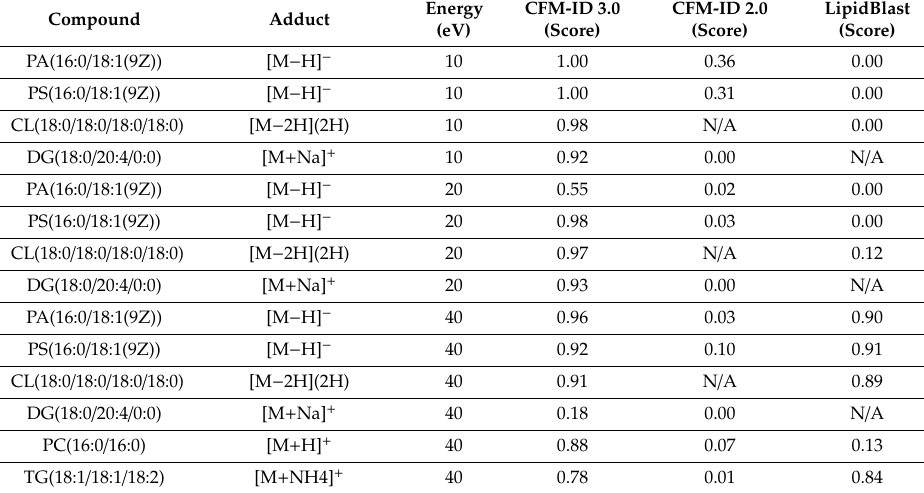
Table 3. Computed spectral similarity scores between experimental and predicted ESI-MS / MS spectra at three energy levels (10, 20, and 40 eV). The results show higher similarities, and thus an improvement when using a rule-based approach (CFM-ID 3.0) over a combinatorial one (CFM-ID 2.0) for the prediction of lipid ESI-MS / MS spectra. The spectral similarities of the LipidBlast-generated consensus spectra further illustrate this trend. When available, the same LipidBlast-generated consensus spectrum was used for comparisons at each energy level. N / A corresponds to cases where (1) the adduct type was not covered by CFM-ID 2.0 at all, or (2) the adduct type was not covered by LipidBlast for the chemical class to which the test compound